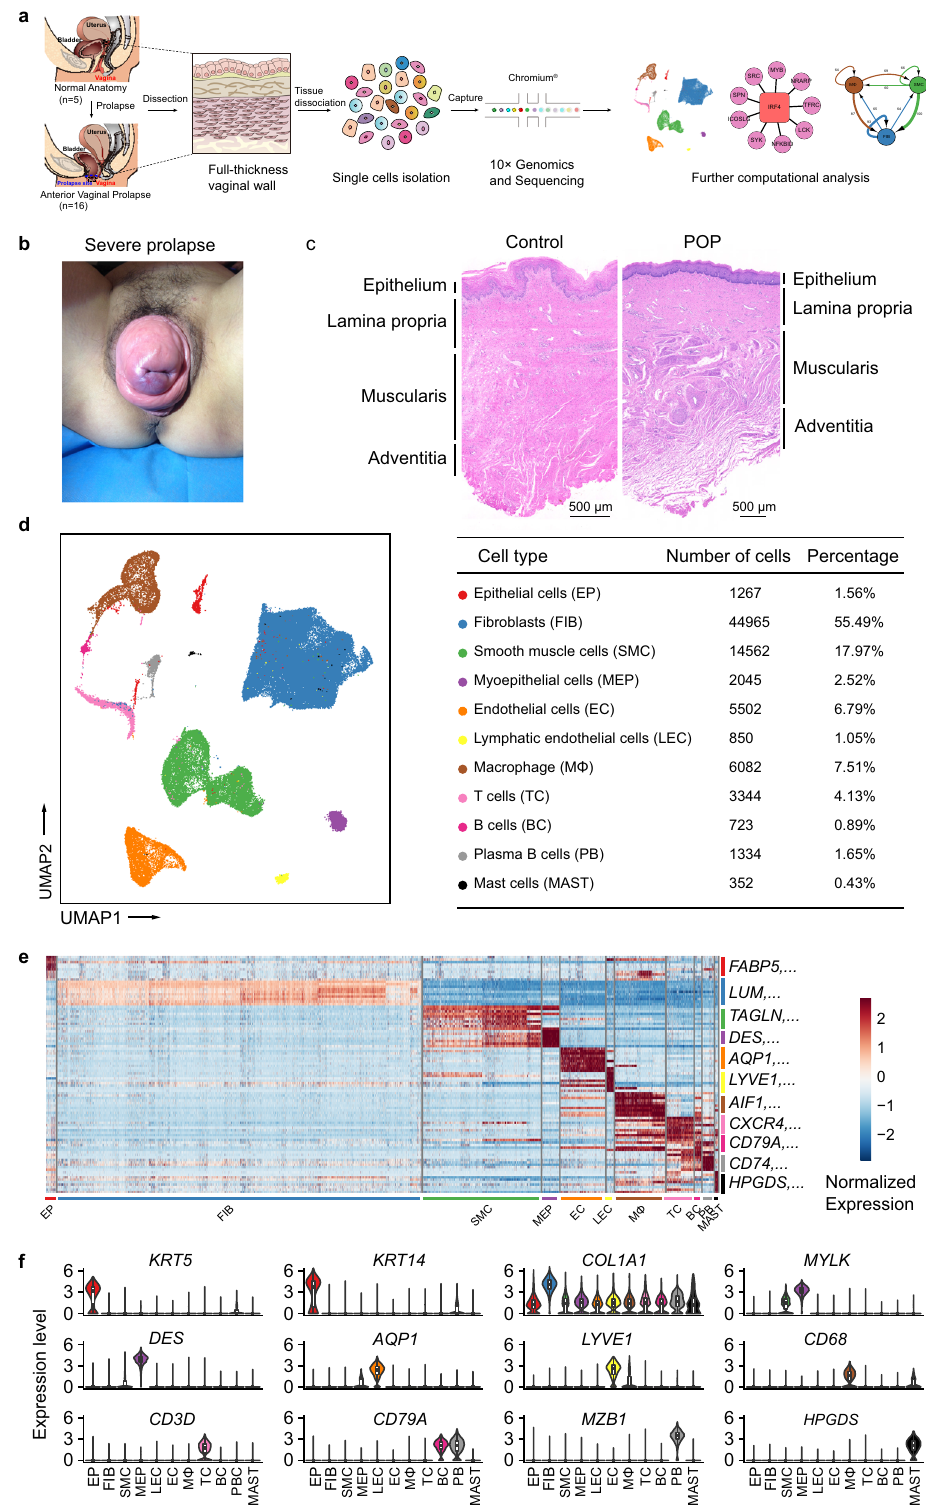
de fi nitions (Supplementary Fig. 1d). To validate the presence of some representative cell types, we performed immunostaining for non-immune cells and fl ow cytometric analysis for immune cells (Supplementary Fig. 2b, c). Taken together, we revealed the cellular composition of the vaginal wall and provided a comprehensive representation of vaginal wall cells for further studies of